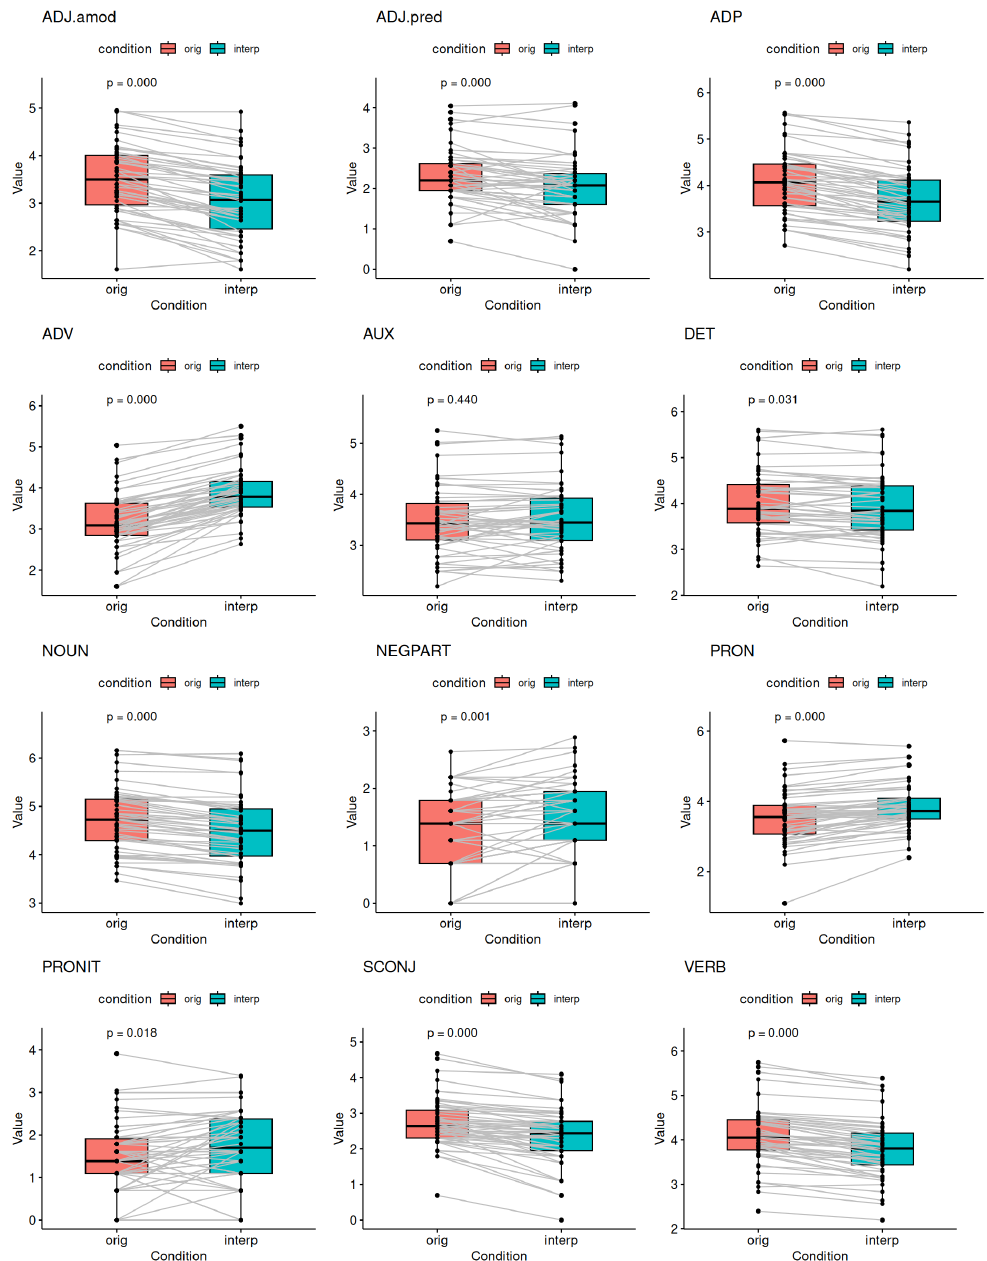
Figure A4. Pairwise comparisons of POS-frequencies (log-transformed) per speech in originals and translations. Each line connects data points representing the same speech (orig: original, interp: